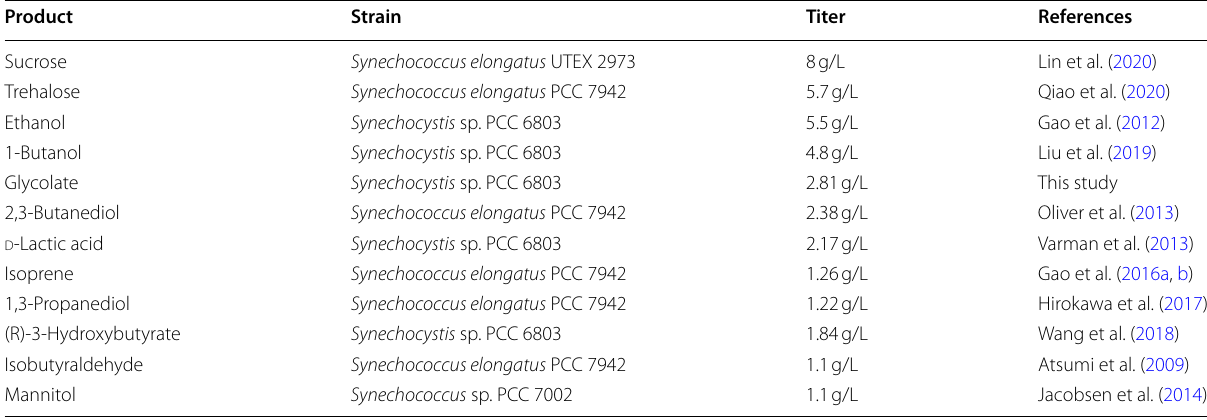
Table 2 Chemicals synthesized from CO